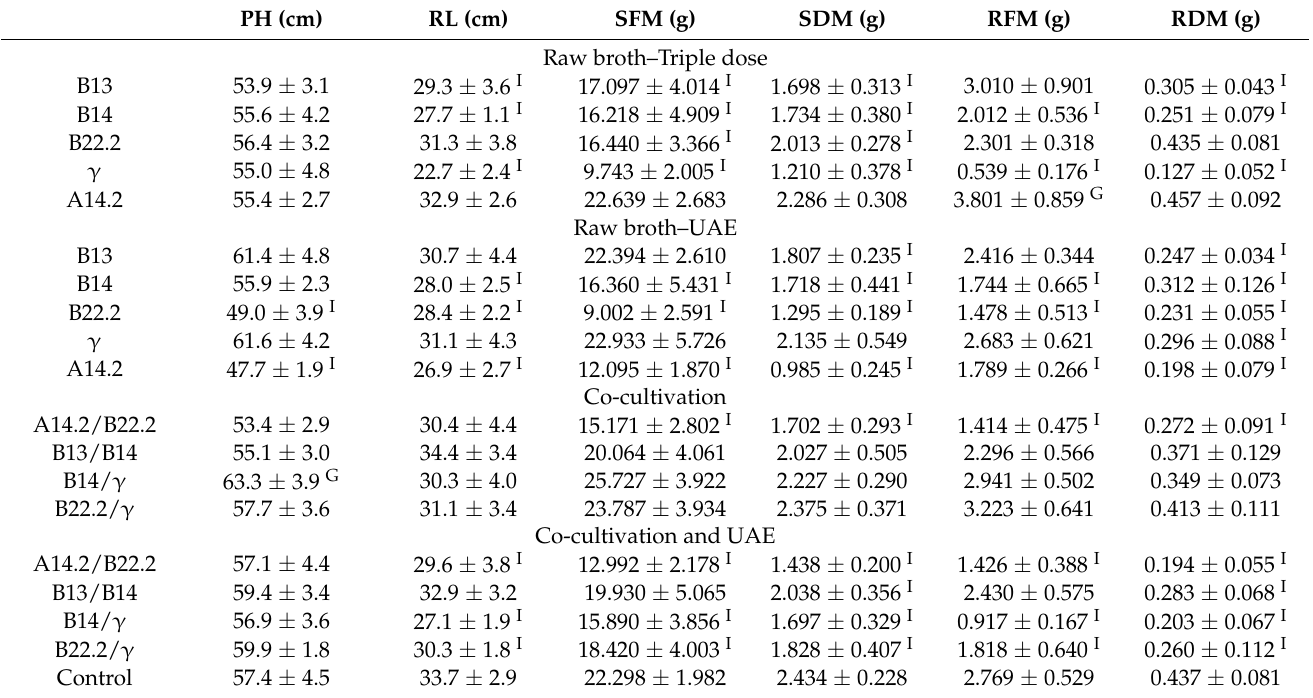
Table 3. Effects of metabolites from the crude broth, triple dose and UAE, co-cultivation, and co-cultivation and PF-UAE on E. crusgalli parameters at 14 days after application (DAA).